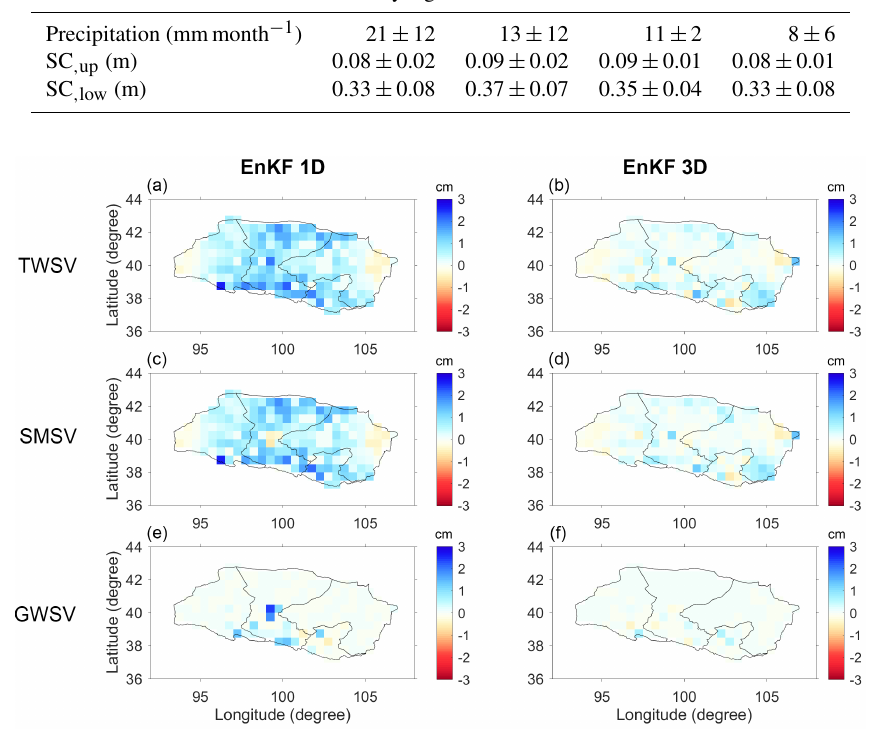
Figure 11. TWSV, SMSV, and GWSV updates of October 2002 without the correlation error applied (EnKF 1D) and with the correlation error applied (EnKF